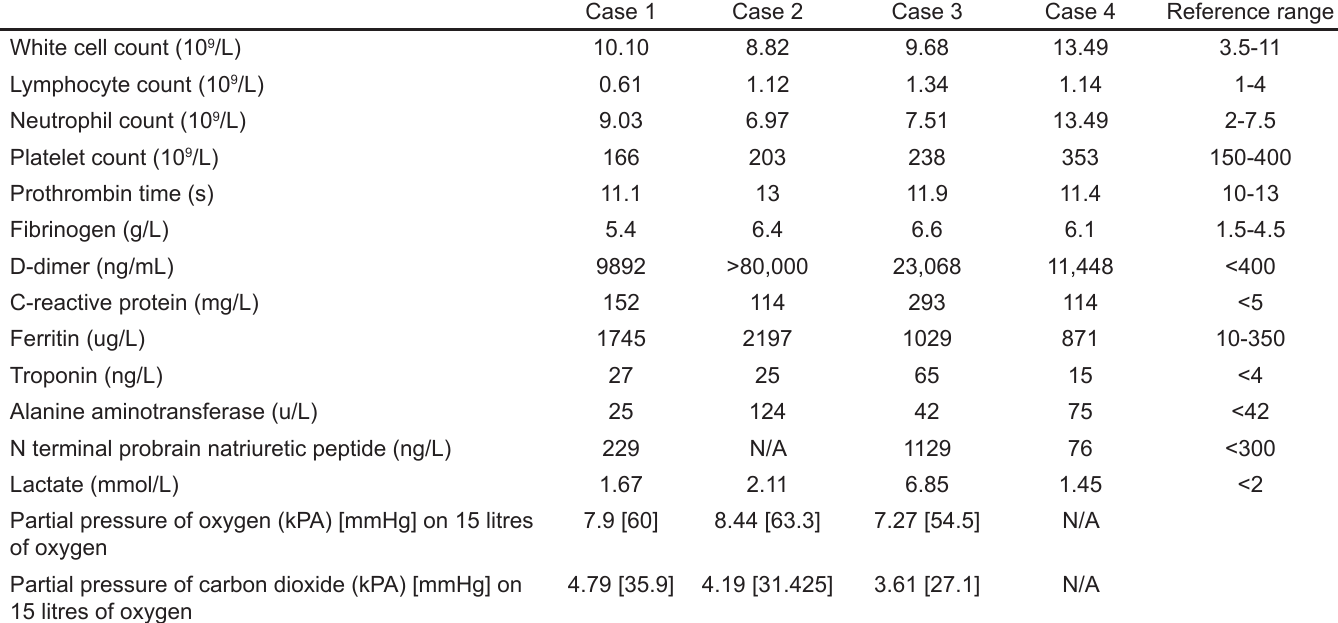
Table 1. Laboratory features of cases 1-4 of COVID-19 patients presenting with an acute pulmonary embolus.